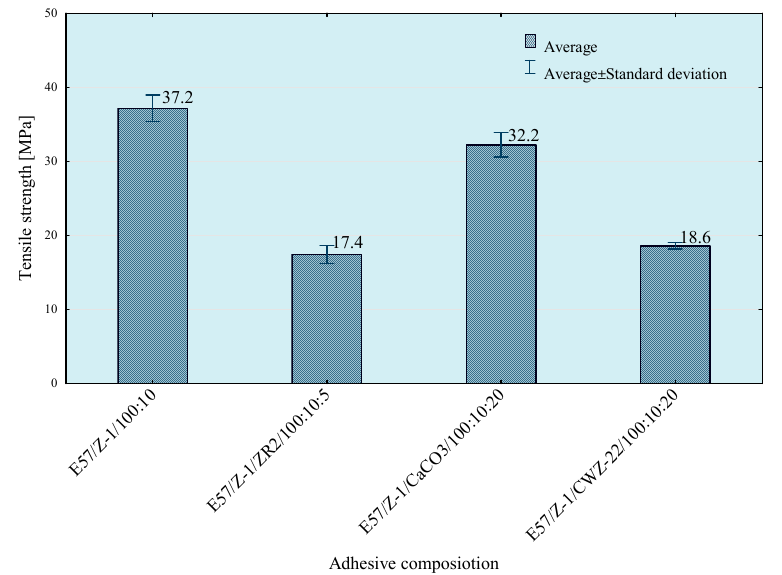
Figure 19. Results of tests of average tensile strength of compositions prepared with 5 mixing methods at 1170 rpm.